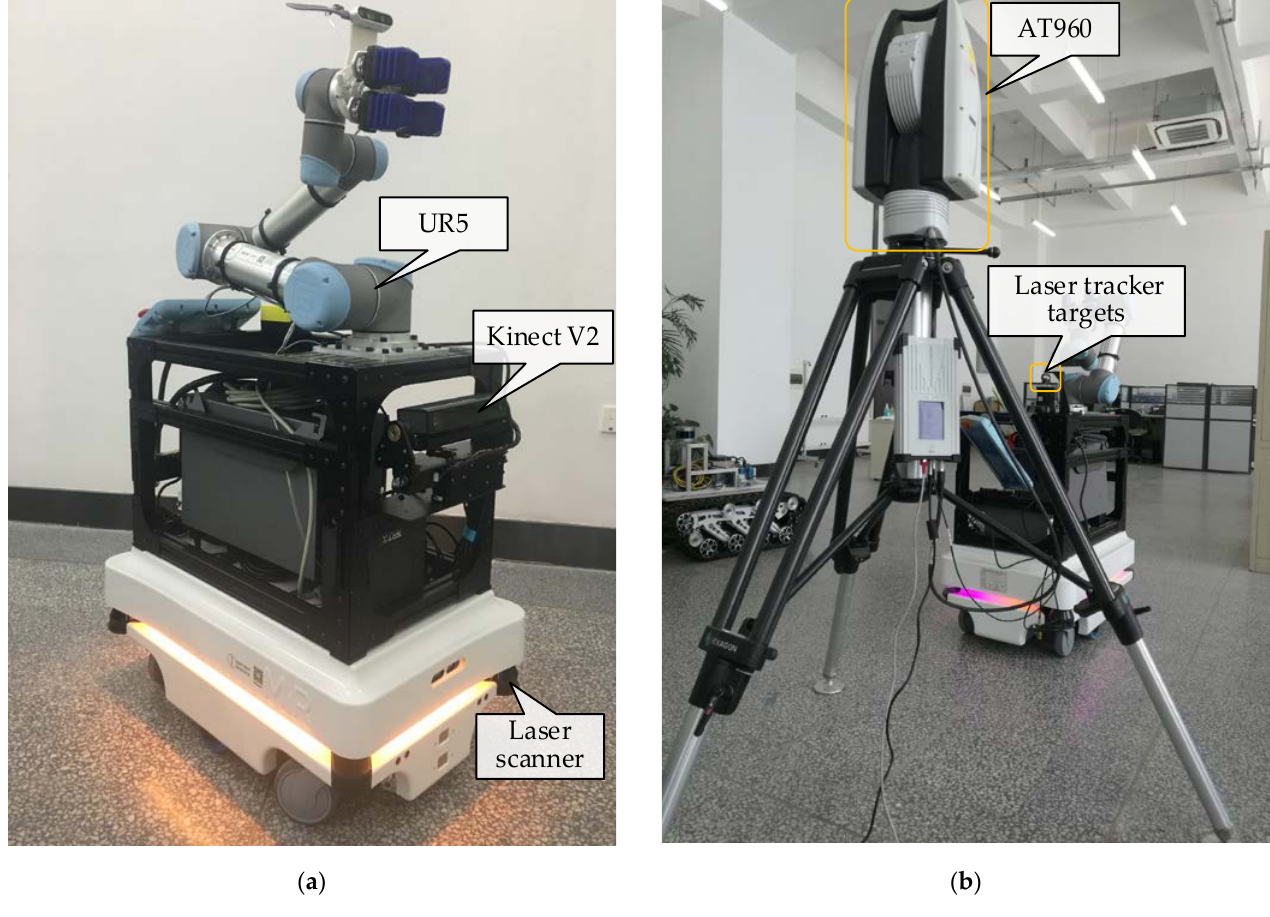
Figure 14. Experiment setup. ( a ) The experimental platform; ( b ) The measuring equipment.